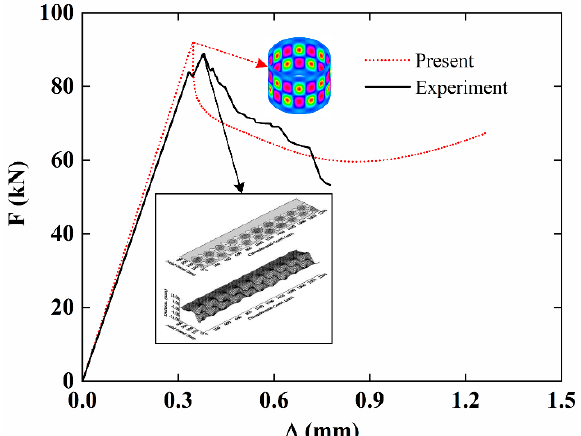
Figure 3. Comparison of load-edge shortening curves of imperfect carbon-fiber-reinforced composite cylindrical